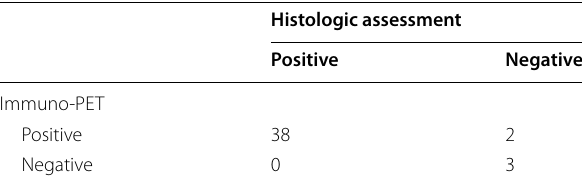
Sensitivity and specificity of GPC3-targeted immuno-PET compared to histologic